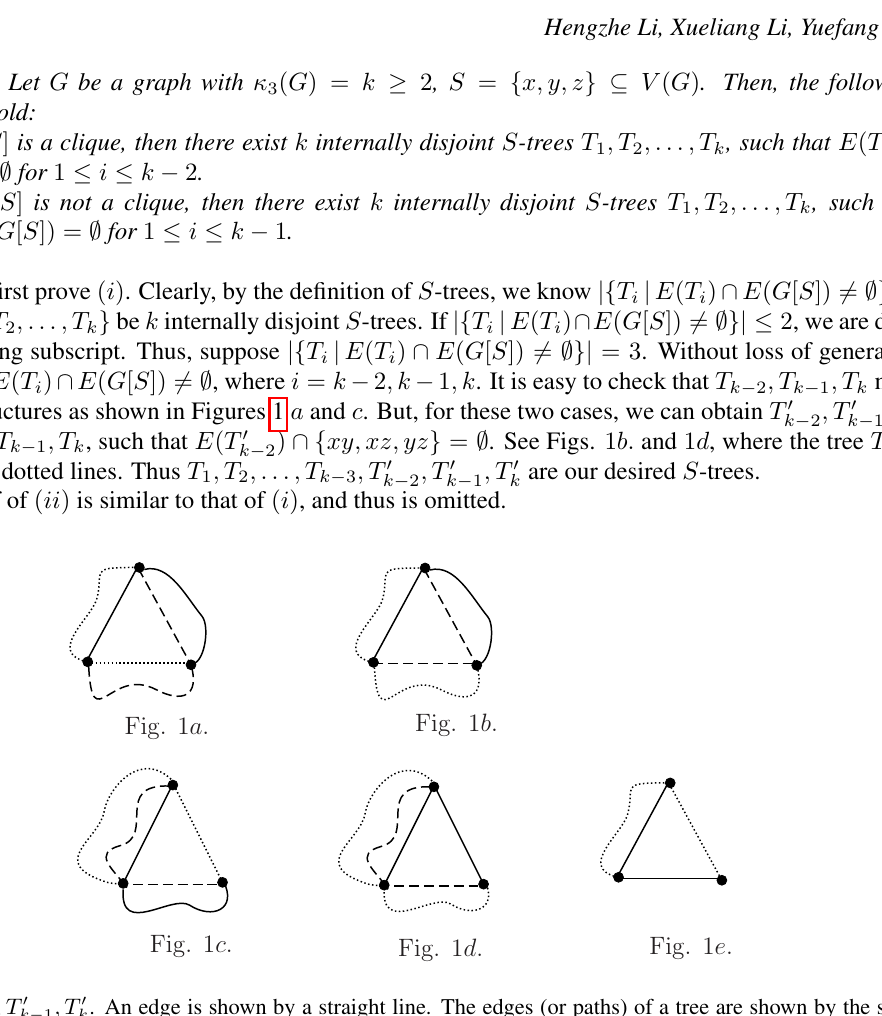
, T (cid:48) , T (cid:48) Fig. 1: T (cid:48) . An edge is shown by a straight line. The edges (or paths) of a tree are shown by the same k k − 1 k − 2 type of